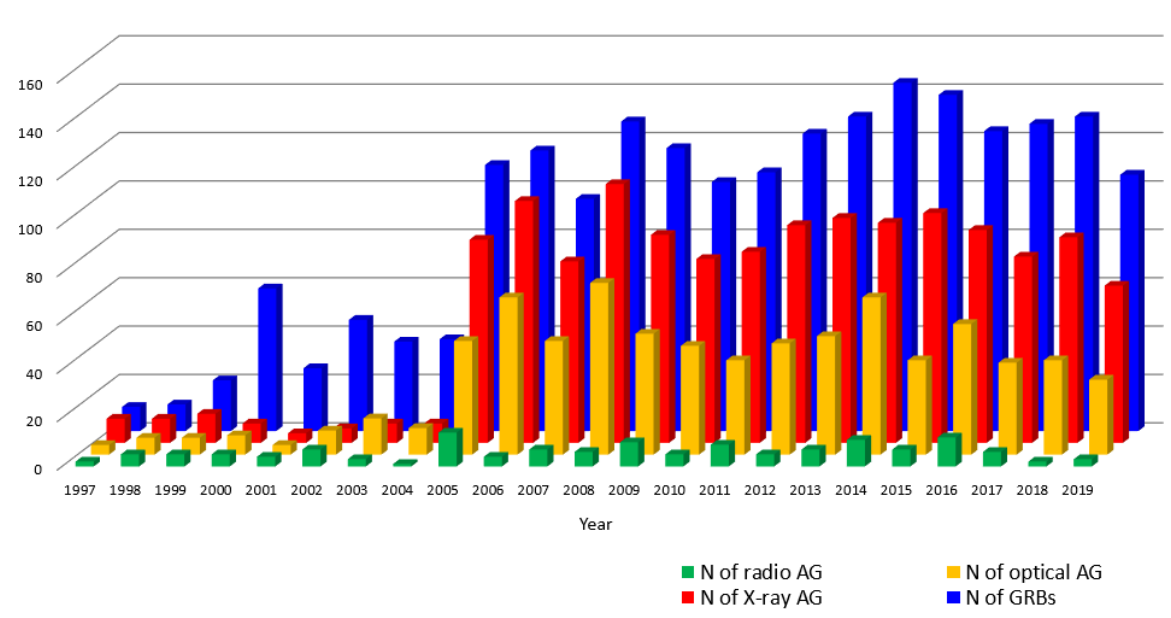
Figure 1. Statistics of GRB detections with localization in general of better than 3 arcminutes (radius). The bars indicate (from background to foreground) number of total GRBs discovered, number of X-ray, optical, and radio afterglows discovered per year. (The statistics based on J. Grainer webpage